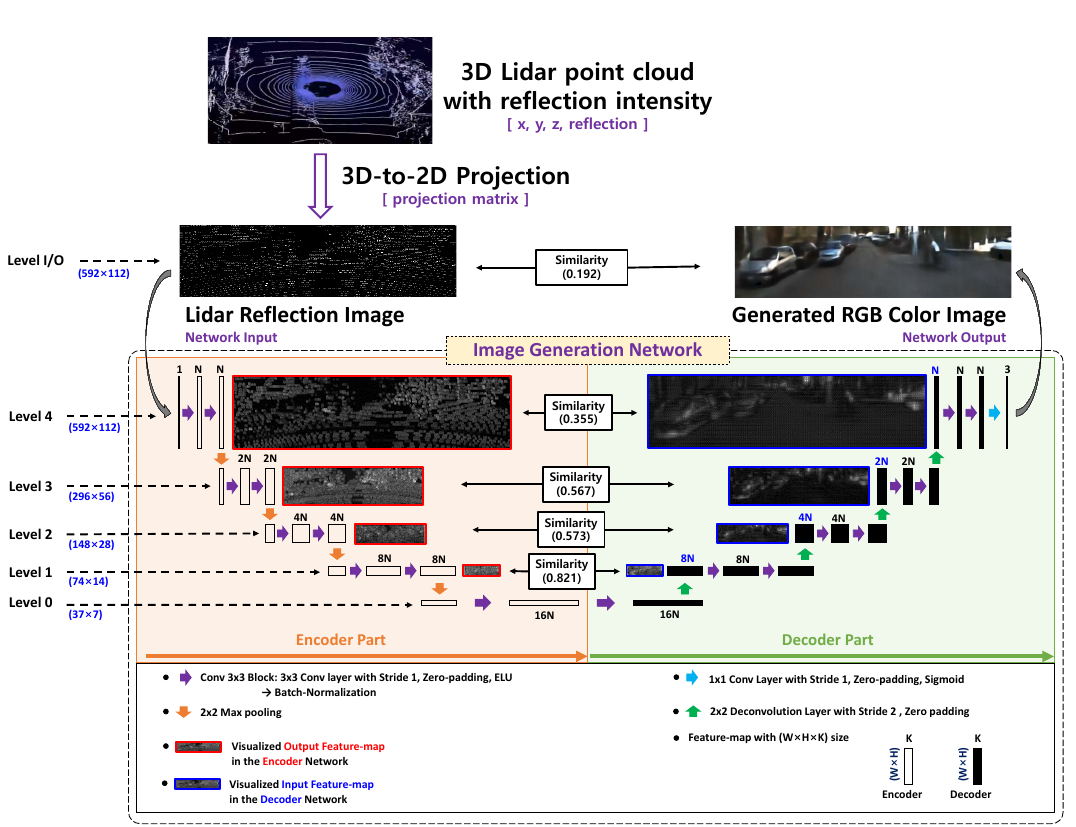
Figure 2. Encoder-decoder structured fully convolutional network (ED-FCN)-based color image-generation network from light detection and ranging (LiDAR) reflection data; the network has five levels including transition level (level 0); for each level, the similarities between representative feature maps of encoder and decoder parts are provided; the kernel size of the convolution filter is 3 × 3 × C L , where C L = 2 ( 4 − L ) × N represents the number of channels at the level L